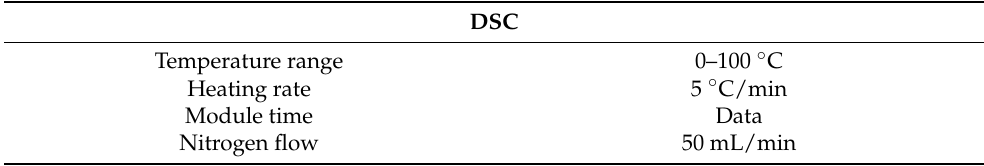
Table 2. DSC parameters.